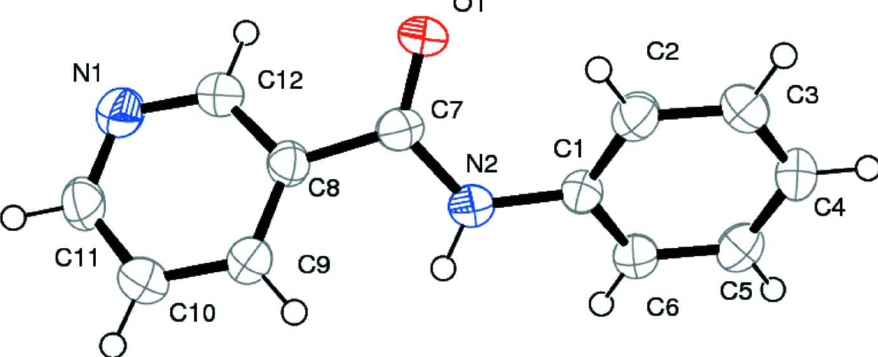
Figure 1 The molecular structure of the title compound shown with 50% probability displacement